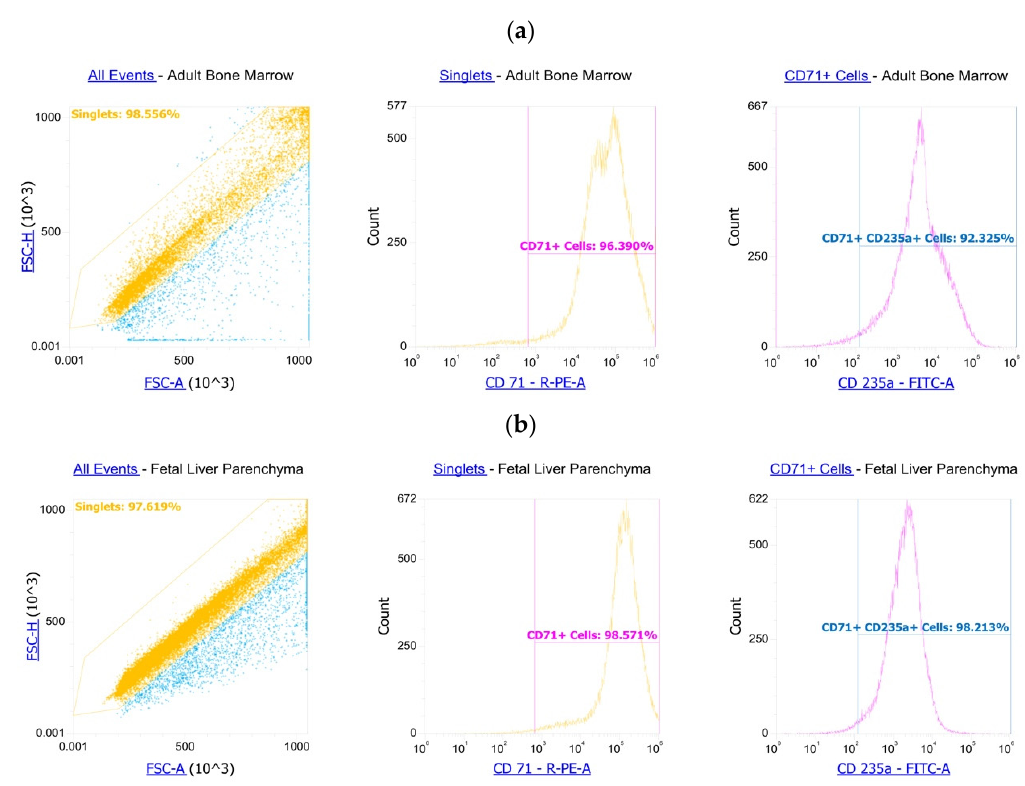
Scheme 1. CECs’ purity assessment by flow cytometry: ( a ) CECs from adult bone marrow ( b ) CECs from fetal liver